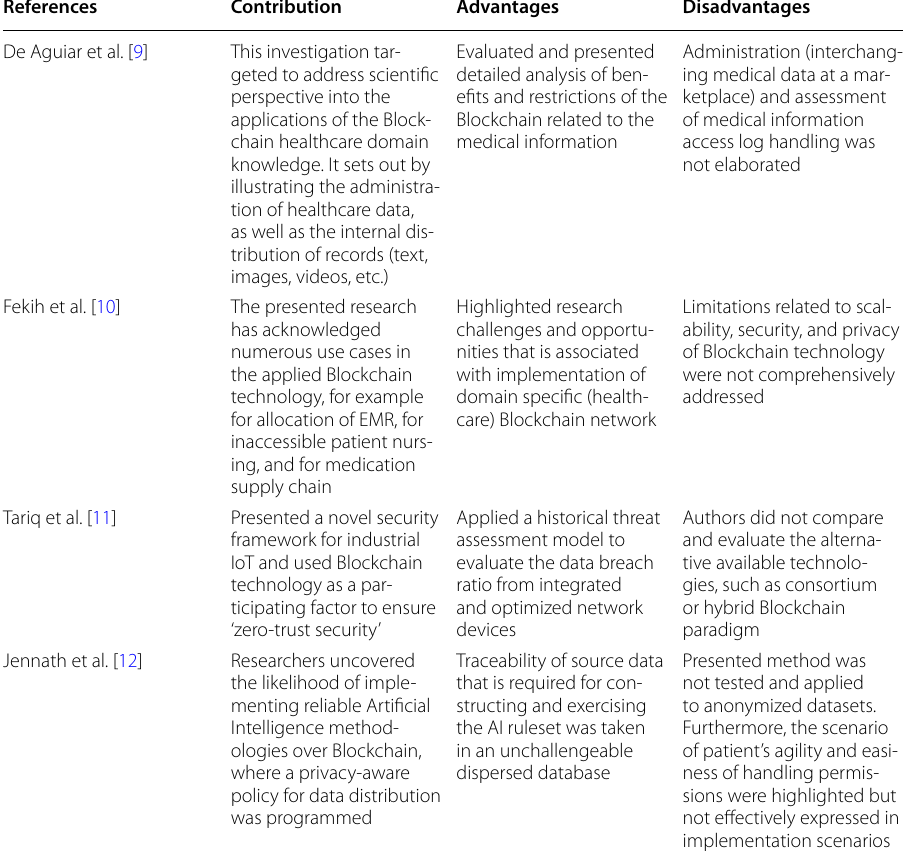
Table 1 Assessment of existing methodologies for healthcare using